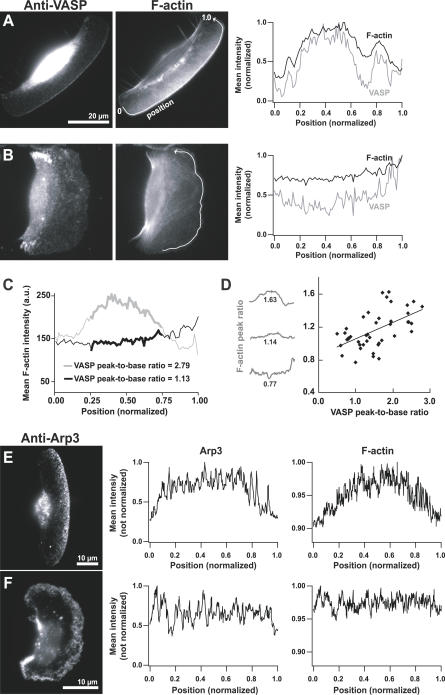
VASP Enrichment at the Leading Edge Correlates with Peaked F-Actin Distributions(A) The distributions of VASP (gray line in the graph) and F-actin (black line in the graph) were measured along the length of the leading edge of cells (position indicated by the arrow). The cell shown has VASP enriched at its smooth leading edge (VASP peak-to-base ratio = 1.84). The distribution of F-actin along the leading edge of this smooth cell is peaked in the middle and strongly correlates with that of VASP (r2 = 0.82, p < 0.0001). Scale bar = 20 μm.(B) A keratocyte with rough leading edge and very weak VASP at the leading edge (VASP peak-to-base ratio = 0.76) has a very flat distribution of VASP (gray line in the graph) and F-actin (solid black line in the graph) measured along the leading edge (arrow). The distributions of VASP and F-actin along the leading edge of this cell strongly correlate with each other (r2 = 0.81, p < 0.0001). Additionally, the distributions of VASP and F-actin of the entire population of keratocytes strongly correlate (<r> = 0.71, SD = 0.23, p < 0.0001, n = 43).(C) The F-actin density along the leading edge of a representative coherent cell with high VASP peak-to-base ratio—2.79 (gray line)—is increased compared to that of a decoherent cell with low VASP peak-to-base ratio—1.13 (black line). Mean intensity values are not normalized and were obtained from keratocytes imaged from the same coverslip. F-actin distributions between different cells were compared by calculating a ratio (F-actin peak ratio) of the mean F-actin intensity values from the middle half of the leading edge (0.25 to 0.75 position along the edge, indicated by the thick regions of each line in the graph), which generally correspond to the highest intensity values in peaked F-actin distributions, to the mean of the F-actin values from the rest of the leading edge (positions 0 to 0.25 and 0.75 to 1.00 along the edge, indicated by the thin regions of each line). Cells with peaked F-actin distributions had larger F-actin peak ratios than did cells with flat distributions. The F-actin peak ratio of the coherent cell (gray line) is 1.45, whereas that of the decoherent cell (black line) is 0.94. Also compare the cells in (A) and (B), which have F-actin peak ratios of 1.56 and 0.94, respectively.(D) VASP peak-to-base ratios significantly correlate with F-actin peak ratios (r2 = 0.31, p = 0.0001, n = 43, solid line).(E, F) For comparisons of F-actin and Arp3, mean intensity values were measured along lines (∼0.5 μm wide) positioned along the leading edge of keratocytes, immediately interior to cell edge. Anti-Arp3 mean fluorescence intensities measured along the leading edge of keratocytes are consistent with those of F-actin. A representative smooth cell (E) exhibits peaked Arp3 and F-actin distributions along the leading edge while a rough cell (F) has flat distributions. Scale bar = 10 μm.